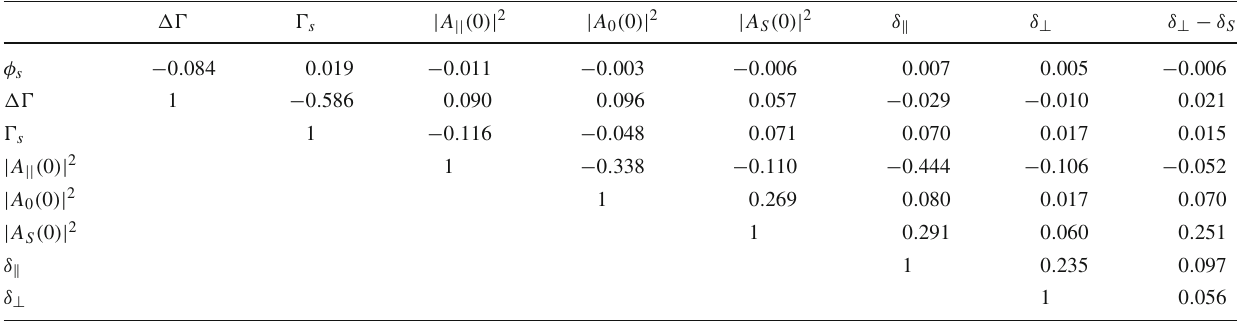
This paper presents a measurement of the time-dependent → J /ψφ decays from an CP asymmetry parameters in B 0 s 80 . 5 fb − 1 data sample of pp collisions collected with the ATLAS detector during the 13 TeV LHC run. The values from the 13 TeV analysis are consistent with those obtained in the previous ATLAS analysis using 7 TeV and 8 TeV data. The two measurements are statistically combined. The CP -violating phase φ s is measured to be − 0 . 087 ± 0.036 (stat.) ± 0.021 (syst.) rad, the decay width difference mass eigenstates, (cid:5)(cid:6) s = 0.0657 between heavy and light B 0 s ± 0.0043 (stat.) ± 0.0037 (syst.) ps − 1 and the measurement Fig. 9 Two-dimensional constraints on the values of δ || and δ ⊥ for solutions (a) and (b) at the level of − 2 (cid:5) ln ( L ) = 2 . 30 , 6 . 18 , and 11 . 83 for their average decay width, (cid:6) s = 0.6703 ± 0.0014 (stat.) respectively created using a full 2D scan. The minimum of the solution ± 0.0018 (syst.) ps − 1 . The measurement of the CP -violating (b) is − 2 (cid:5) ln ( L ) = 0 . 03 higher than the minimum of the solution (a) phase φ s is consistent with the Standard Model prediction, → J /ψ K + K − decay and finally ments, while for the average decay width, (cid:6) s , the comparison LHCb [16] using the B 0 s of the 13 TeV analysis with the current world combined value channels [16,18–21]. The the LHCb result including all B 0 s reveals a tension at the level of 3 σ contours are obtained by interpreting each result as a two- dimensional Gaussian probability distribution in the φ s – (cid:5)(cid:6) s plane. All results are consistent with each other and with the SM [5,52].